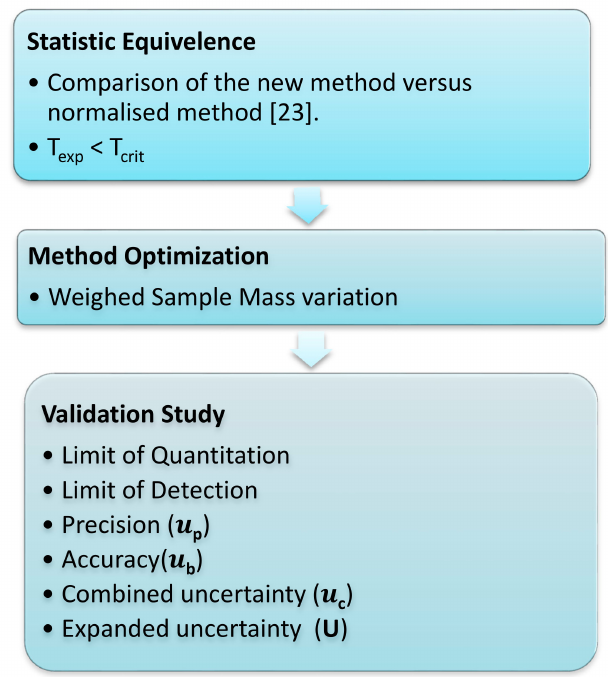
Figure 3. Validation